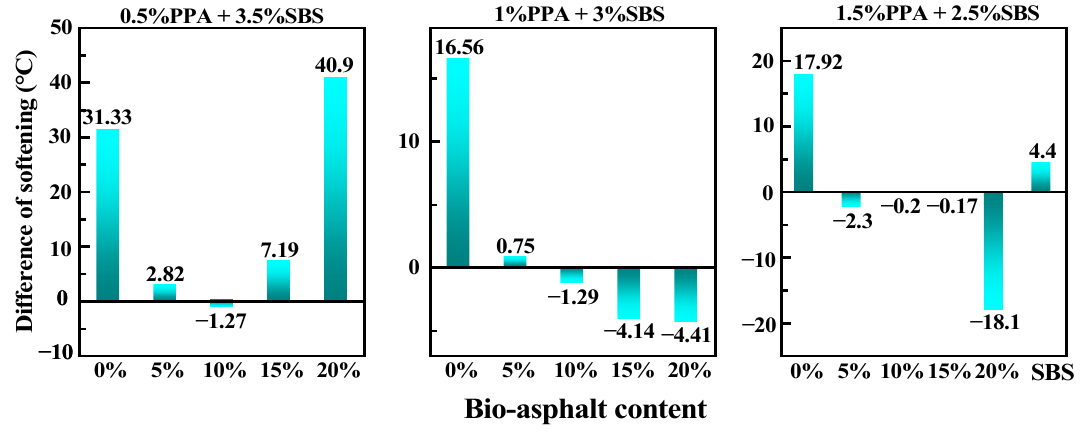
Figure 7. Test results for segregation.